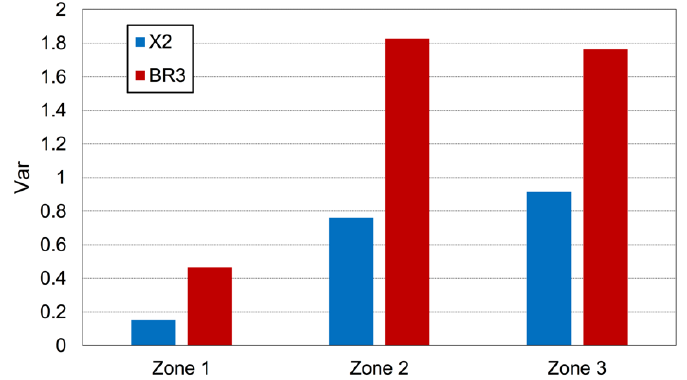
Figure 4. The difference between the Top/Down pressures ( Var ) is significantly less for PTN X2 compared to BR 3 instrument for each zone.